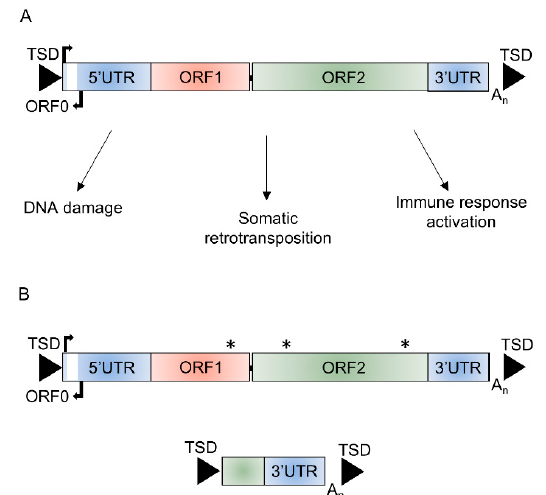
Figure 1. Structure of long interspersed element-1 (L1). ( A ) Schematic of a functional full-length L1